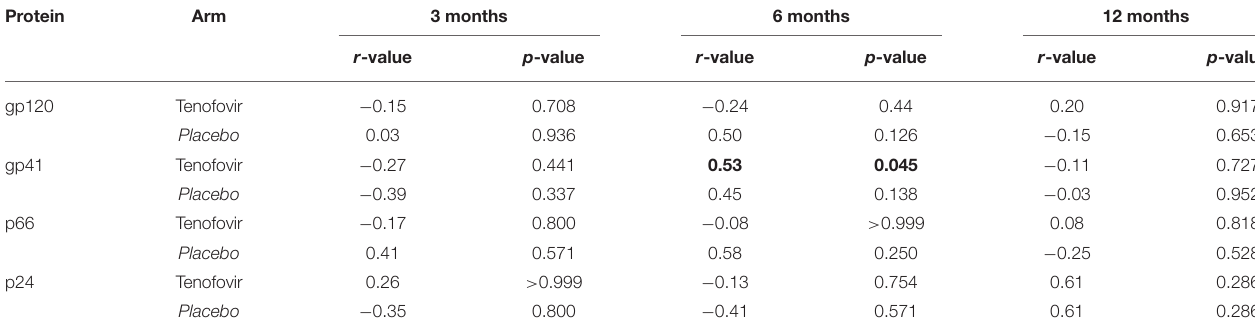
TABLE 2 | Inter-compartmental correlations for the blood and genital tract for HIV-specific ADCC activities in the tenofovir and placebo arms.